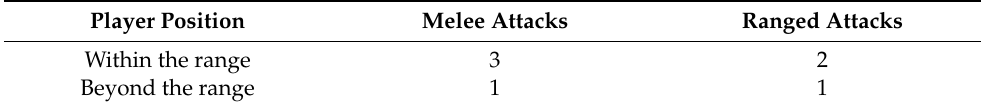
Table 1. GP of enemies that have registered requests to attack after the change. Player Position Melee Attacks Ranged Attacks Within the range 3 2 Beyond the range 1 1